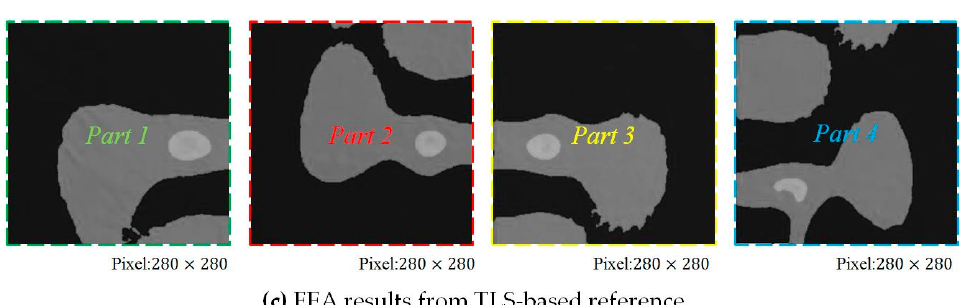
Figure 3. Images of point clouds and finite element analysis (FEA) equivalent stress results.